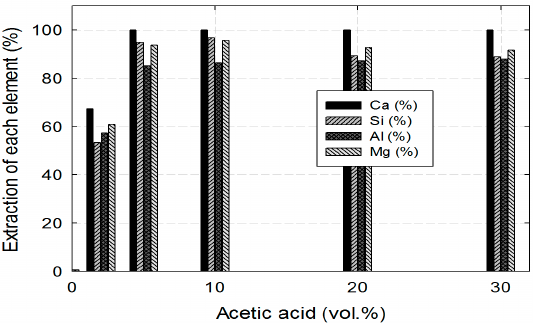
Figure 4. Dissolution of blast furnace slag at 30 °C for 60 min in various concentrations of acetic acid.